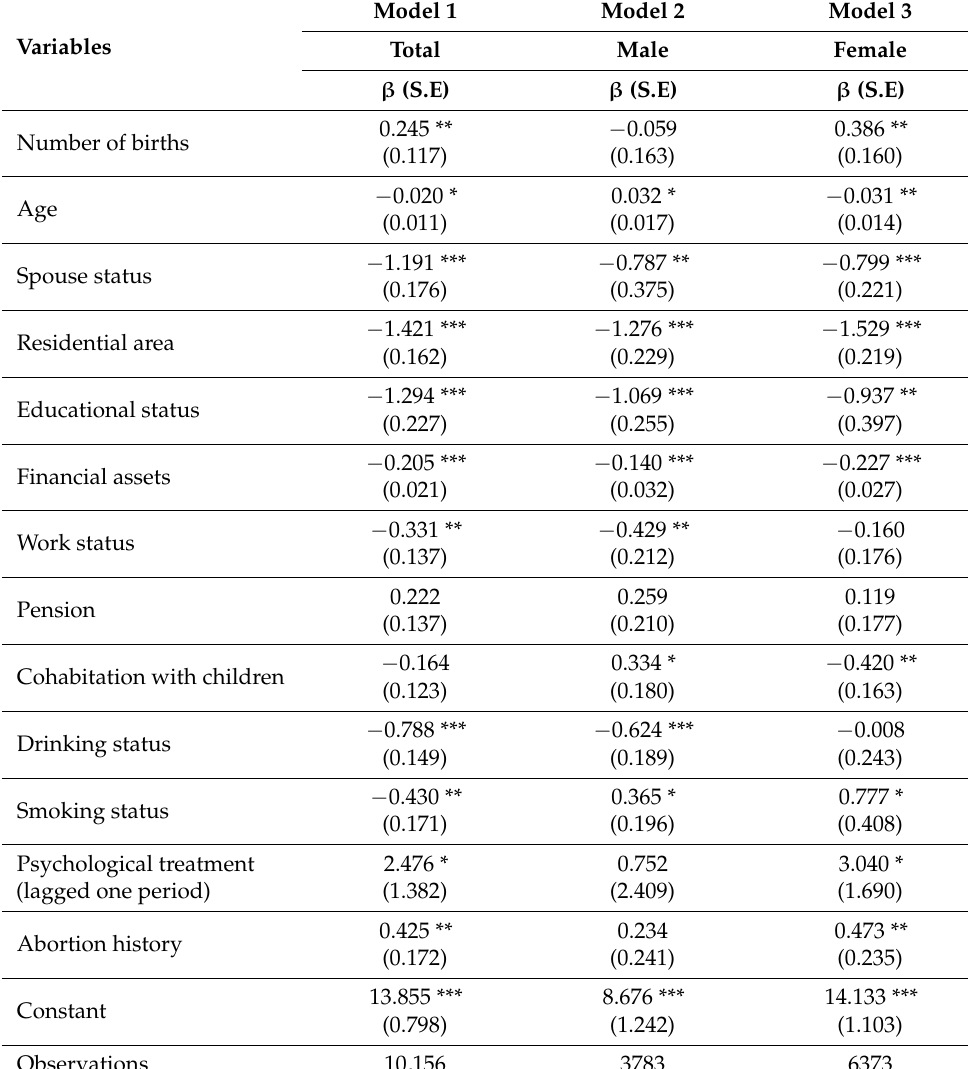
Table 2. Number of births and